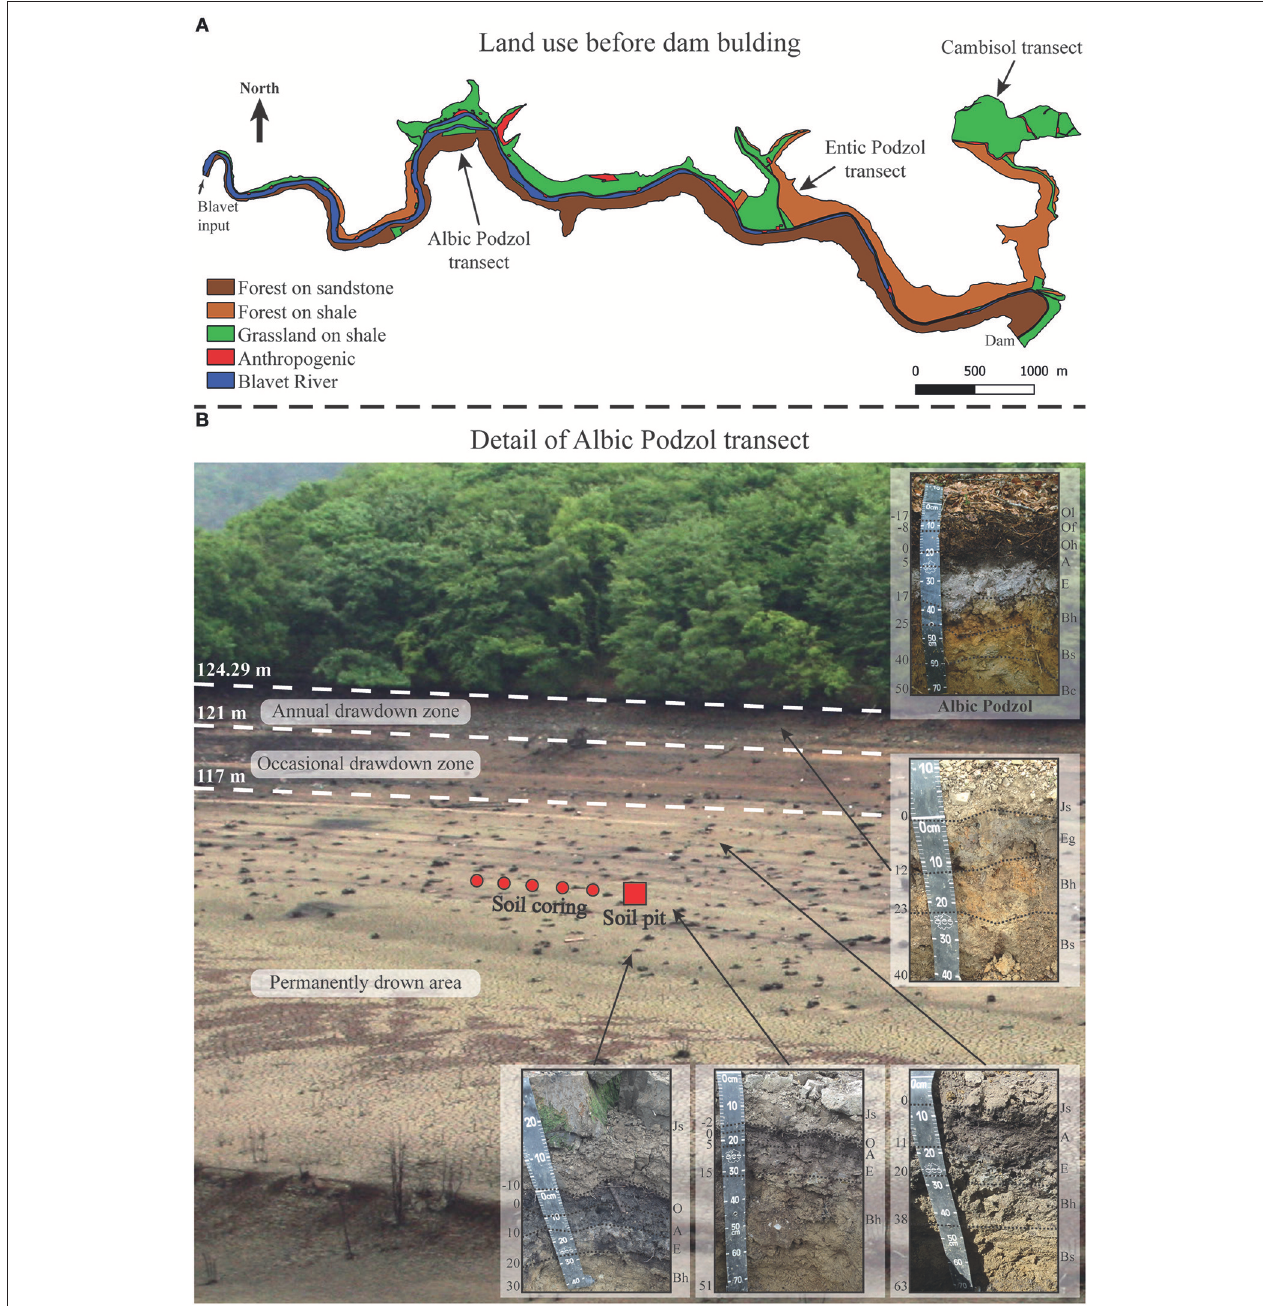
FIGURE 1 | (A) Former land use and geological setting inside the Guerlédan Reservoir. (B) Detail of the Albic Podzol transect.